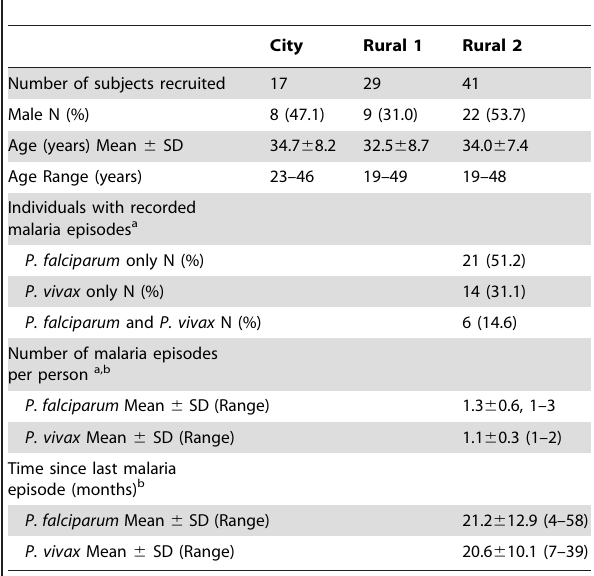
Table 1. Characteristics of study subjects at